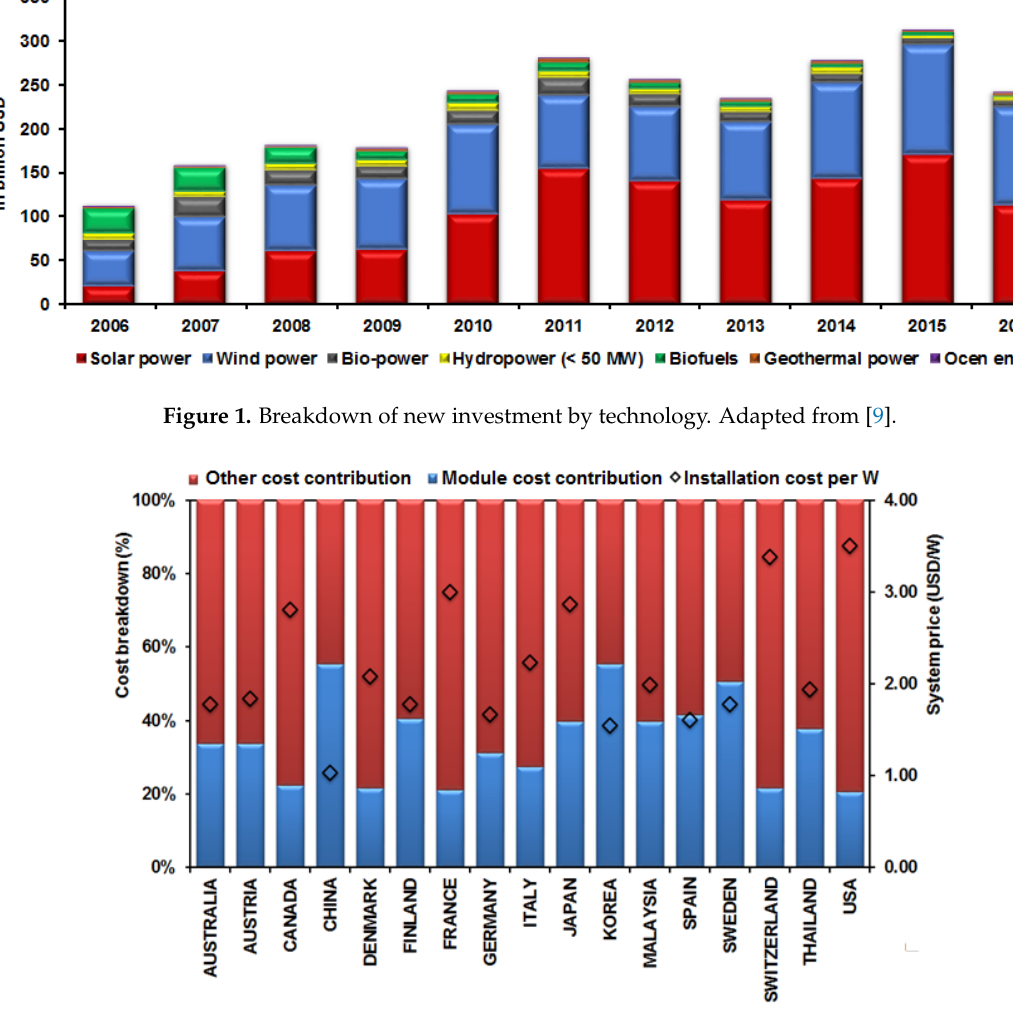
Figure 2. Breakdown of an average on-grid solar photovoltaic (PV) installation cost in 2015 in residential buildings. Adapted from [10].